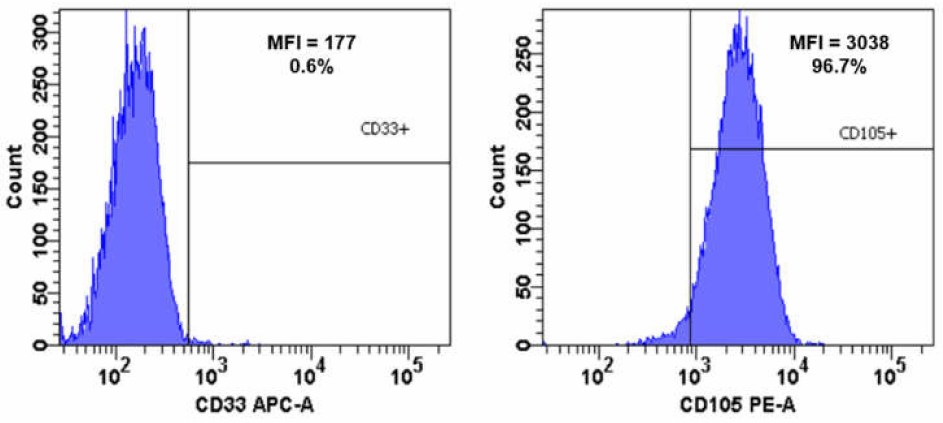
Figure 2. Flow cytometric analysis of mesenchymal stem cell surface marker CD33 (negative) and CD105 (positive).